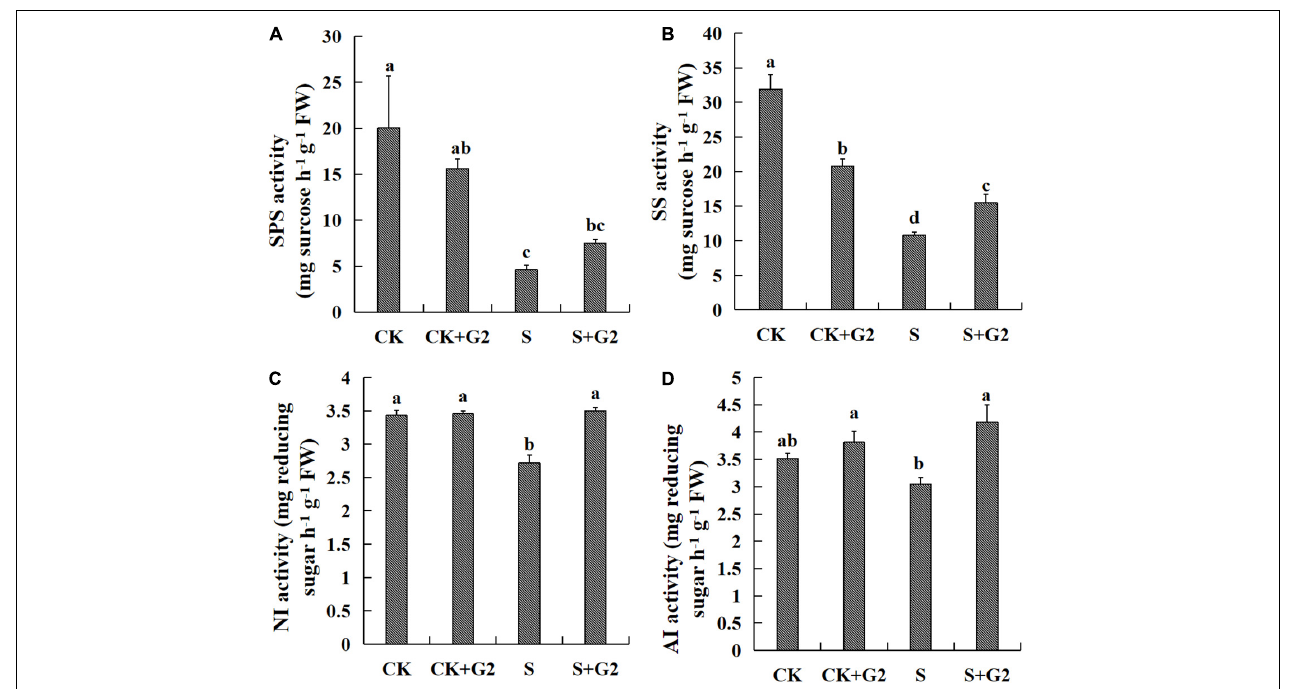
FIGURE 6 | Effects of B. cereus G2 on enzymes related to sucrose synthesis and decomposition in G. uralensis seedlings under control and salt stress conditions. CK, control group; S, salt stress group; CK + G2, control combined with the G2 group; S + G2, salt stress combined with the G2 group. The different letters within the different treatments in the same parameter indicate the significant difference at the 0.05 level. Values are means ± SE ( n = 3). (A) SPS: sucrose-phosphate synthase. (B) SS: sucrose synthase. (C) NI: neutral invertase. (D) AI: acid